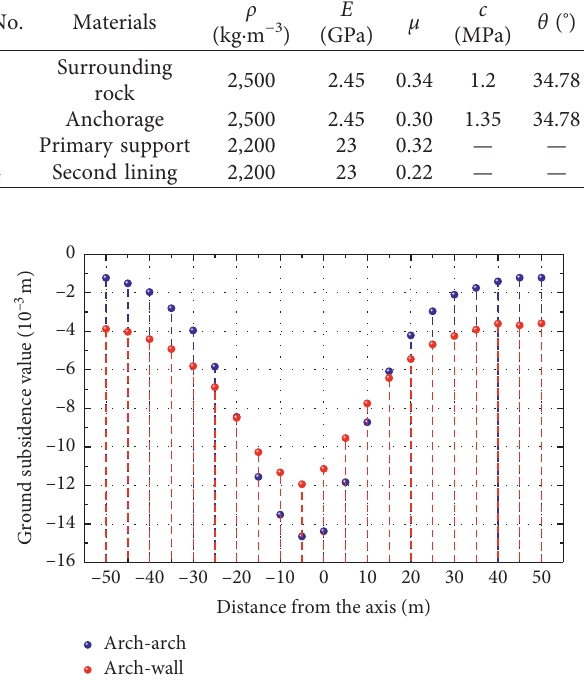
Figure 2: Comparison of two types of structural surface